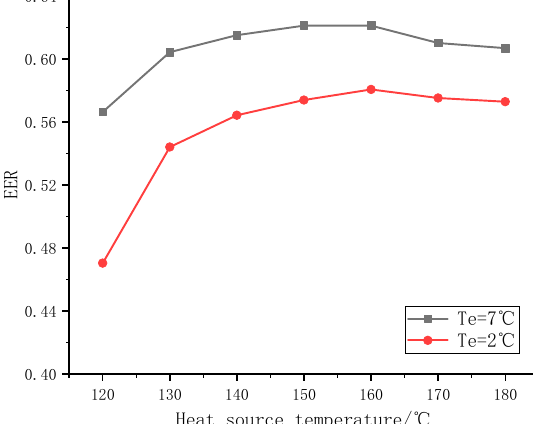
Figure 3. Effect of heat source and evaporation temperatures ( T e ) on system performance.